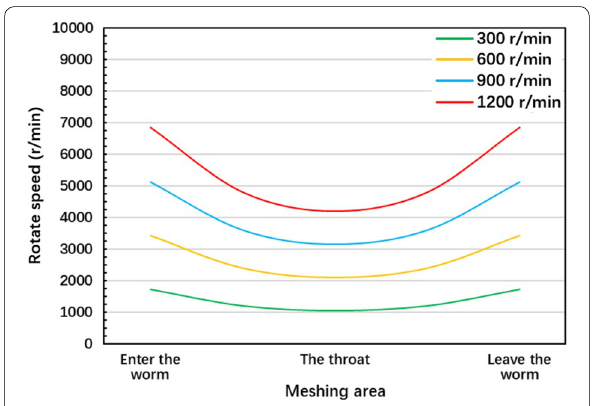
Figure 5 Roller rotation speed